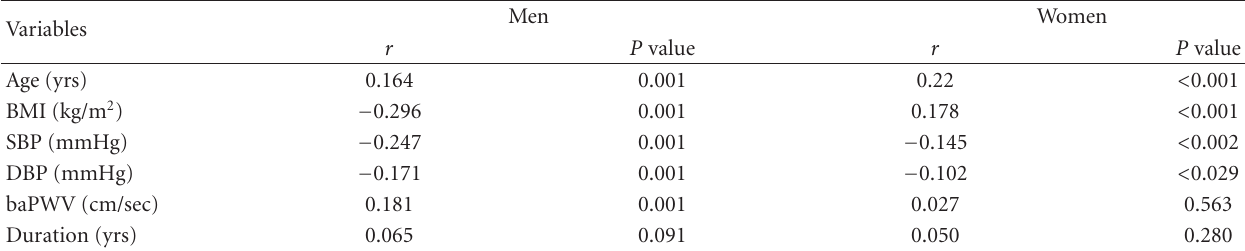
Table 4: Univariate analysis of relationships between ABI and characteristics of subjects with type 2 diabetes mellitus.